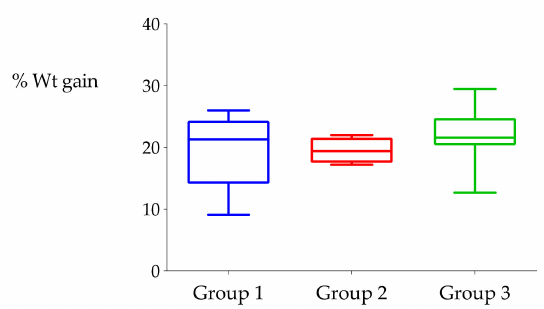
Figure 7. Average weight gain post weaned piglets following challenge with F4 ETEC strain. Group 1, negative group (not infected); Group 2, positive group (not treated and challenged with F4 + ETEC); Group 3; test group (treated with anti-FaeG L. lactis added to the feed from day 0 to day 8 and challenged with F4 + ETEC and). The edges of the boxes are drawn at 25th and 75th percentiles, the middle line is the median, and the lines are drawn at 1.5 IQR (inter quartile